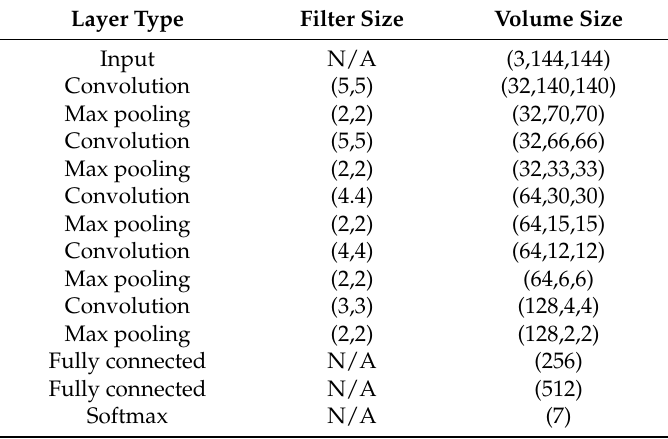
Table 5. Convolutional neural networks (CNNs) structure for surface defect recognition model (reproduced from Yi [40]).